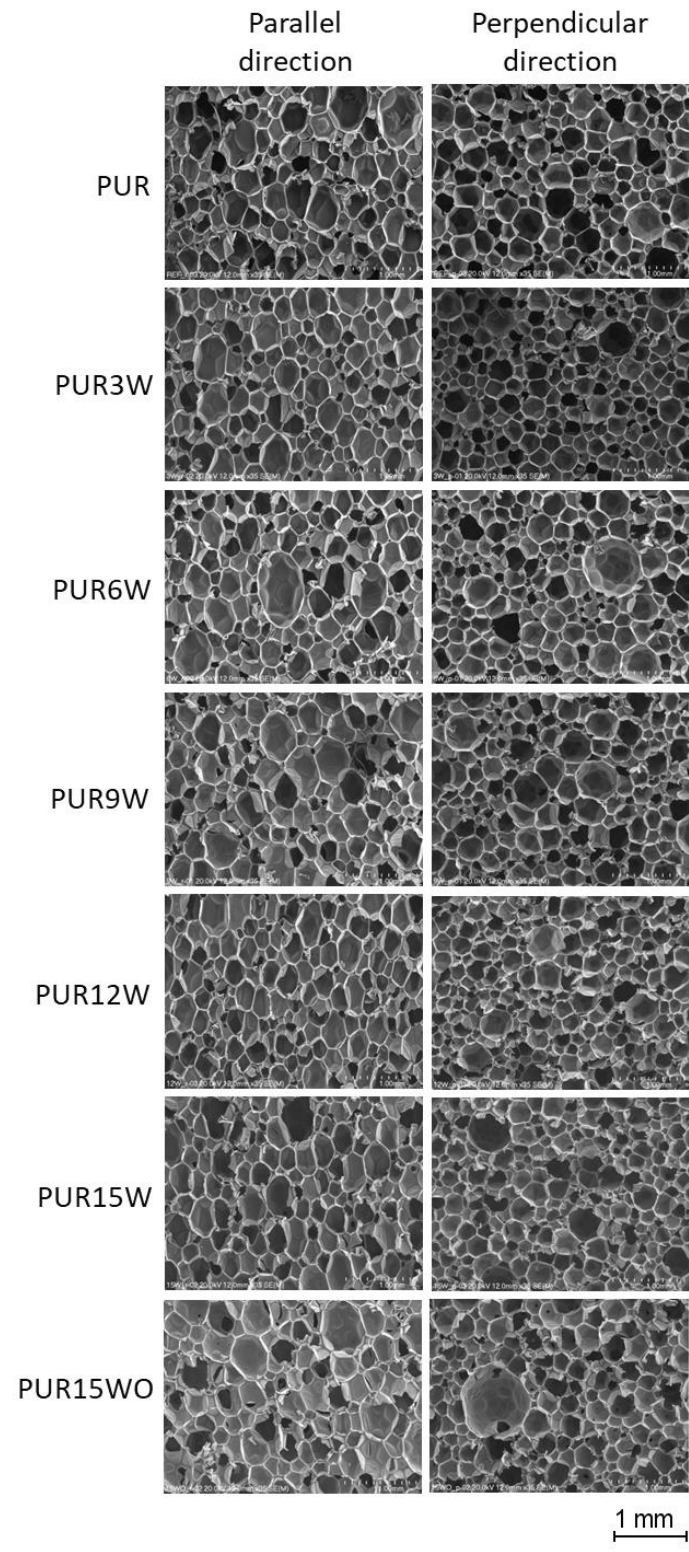
Figure 6. The cellular structure of PUR foams and foams modified with vermiculite.